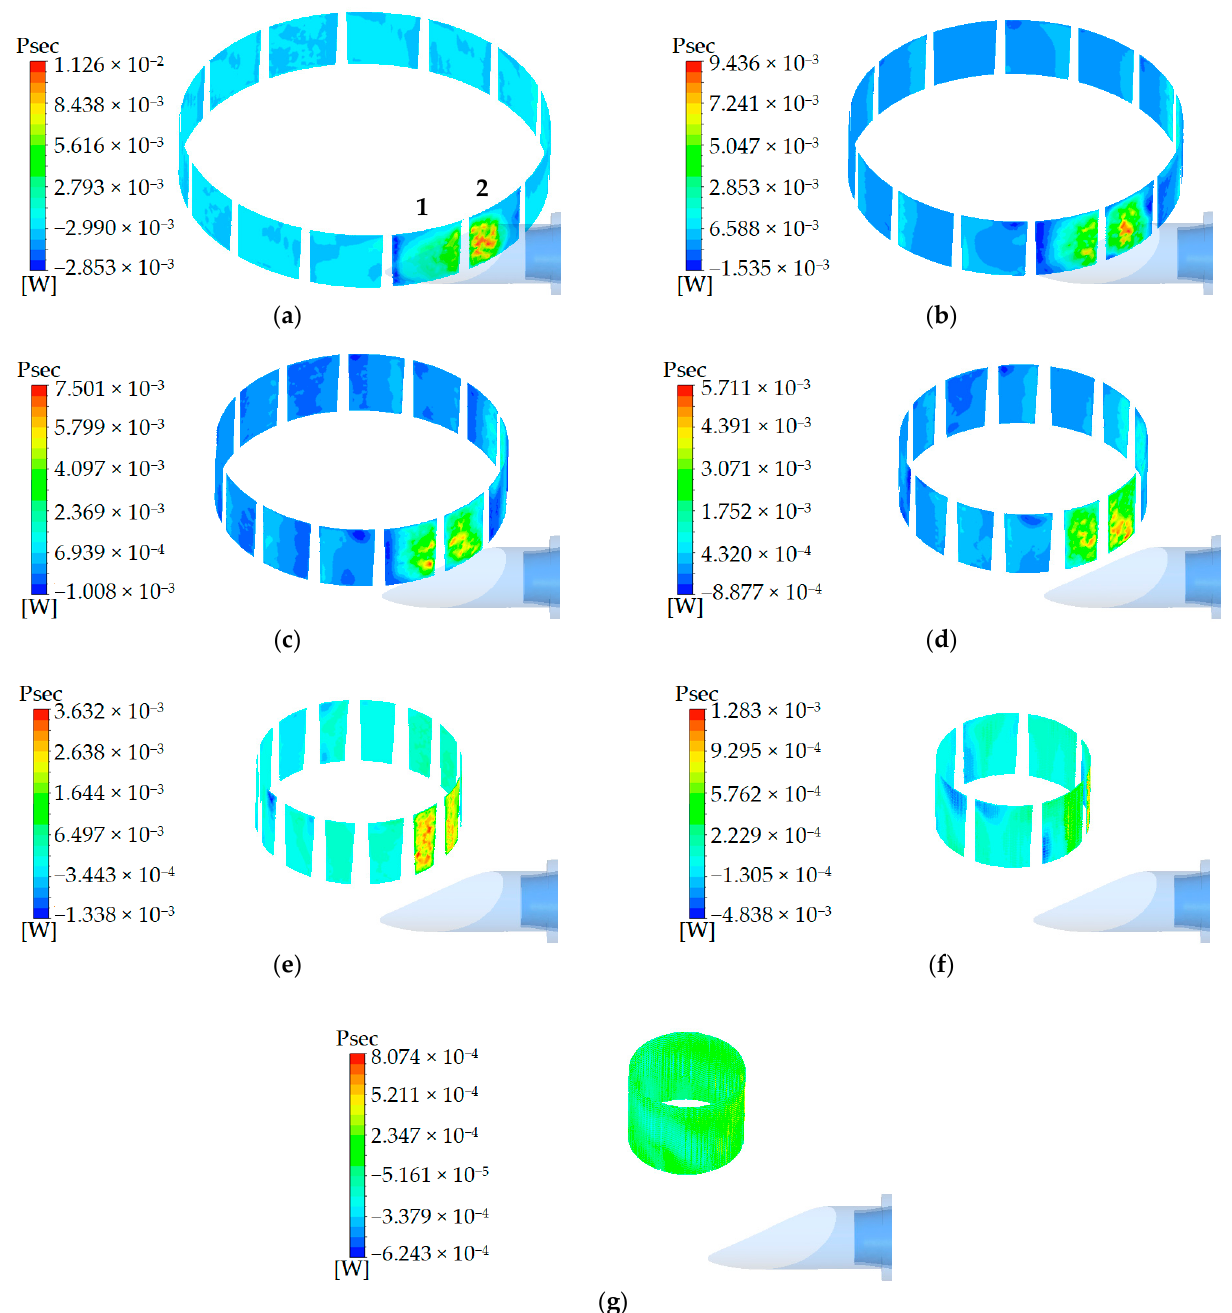
Figure 11. Power contour for cross-sections of the runner. ( a ) D = 175 mm; ( b ) D = 155 mm; ( c ) D = 135 mm; ( d ) D = 115 mm; ( e ) D = 95 mm; ( f ) D = 75 mm; ( g ) D = 55 mm.